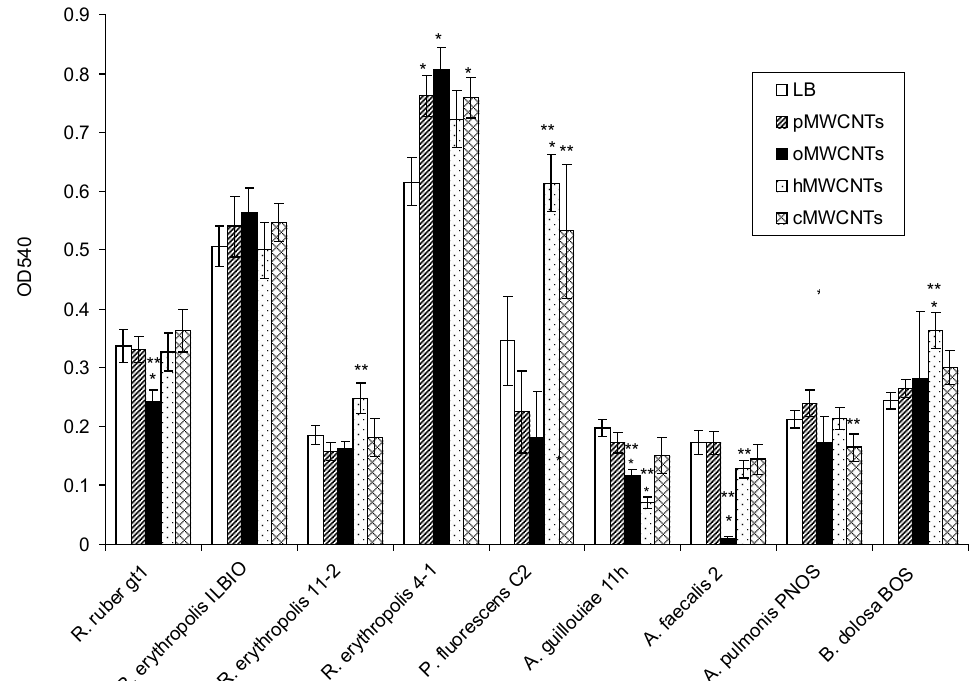
Figure 2. Eradication of biofilms under the influence of 0.9% NaCl solution, 0.9% NaCl solution with pMWCNTs, oMWCNTs, hMWCNTs, and cMWCNTs. * Difference between biofilm eradication under 0.9% NaCl (control) and biofilm eradication under MWCNTs, p < 0.05; ** difference between biofilm eradication under pMWCNTs and functionalized MWCNTs, p < 0.05.